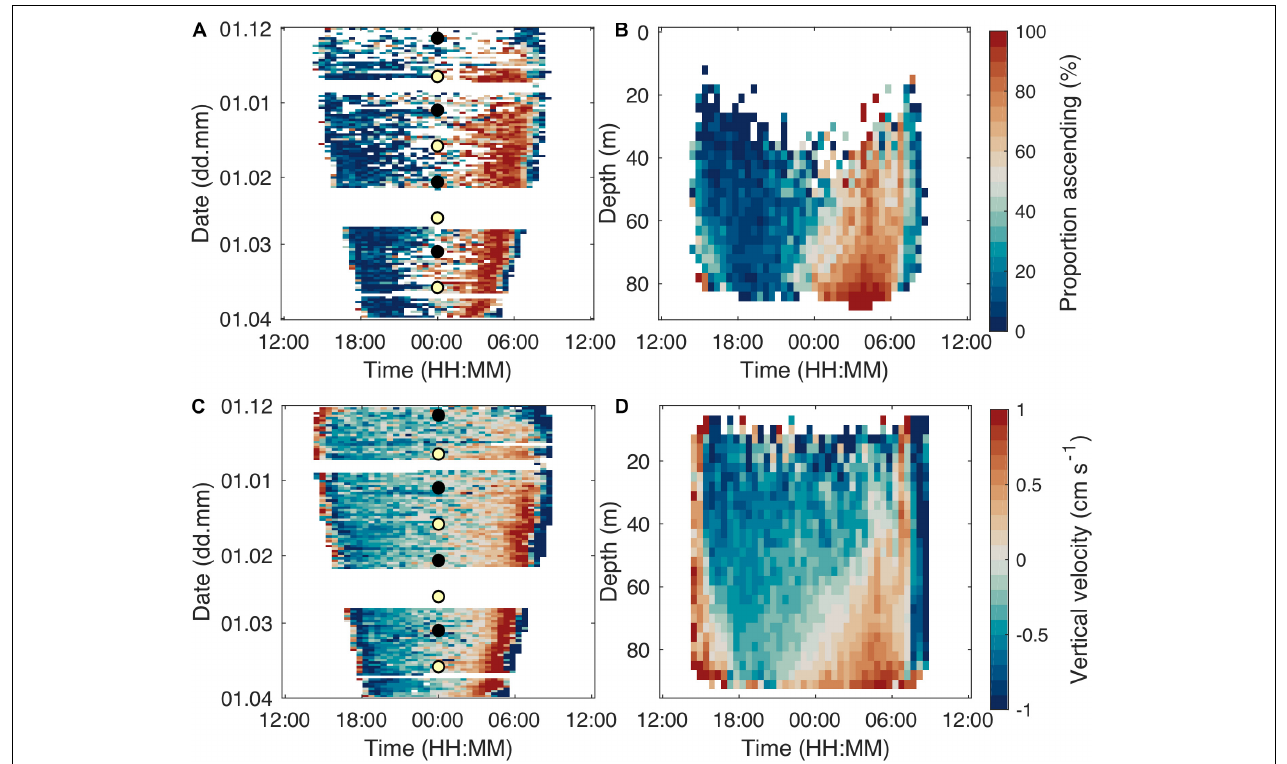
FIGURE 8 | Proportion of (step-wise swimming) ascending tracks, integrated over the whole water column, over daytime and study period (A) . Mean image of proportion of ascending stepping tracks over depth and daytime with data from the whole study period (B) . Warm colors indicate a higher proportion of ascending individuals. Each bin contains data from at least five tracks. Average vertical velocity of step-wise swimming individuals integrated over depth (C) and study period (D) . The circles in (A,C) indicate full moon (yellow fill) and new moon (black